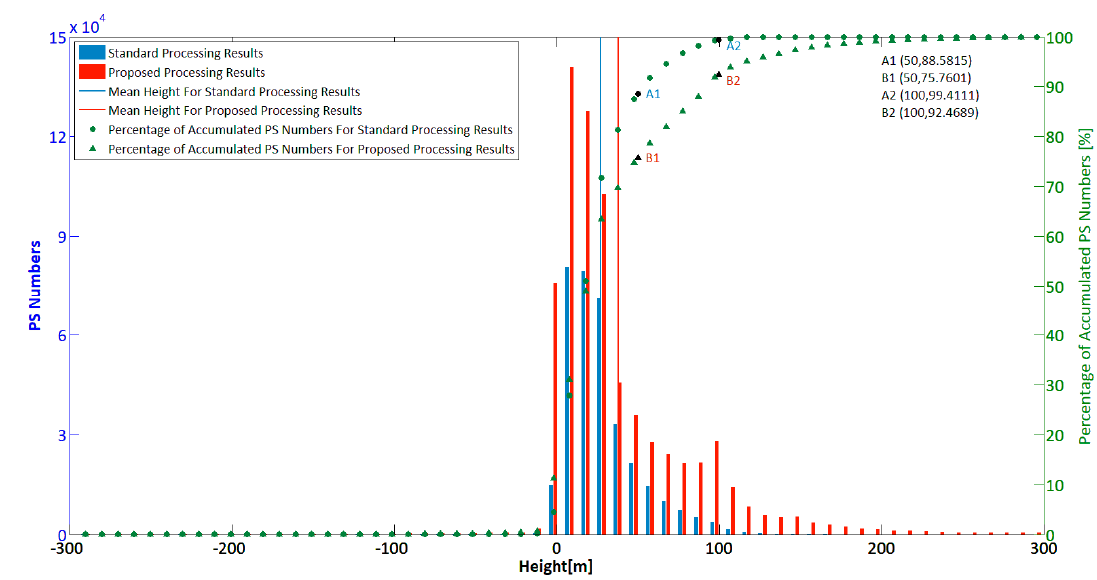
Figure 16. Histogram of PS point heights for both the standard and proposed processing